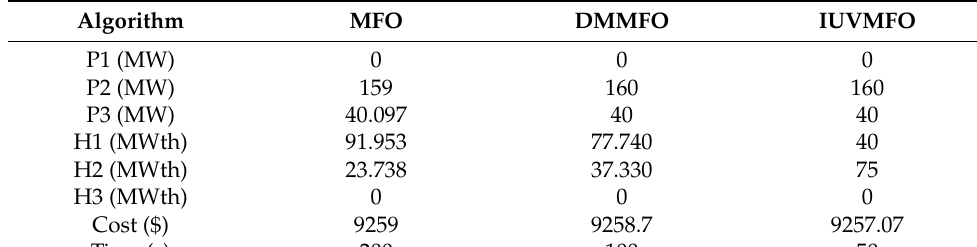
Figure 13. Solution changes for DMMFO running. Table 10. Comparison of results for economic dispatch of cogeneration.